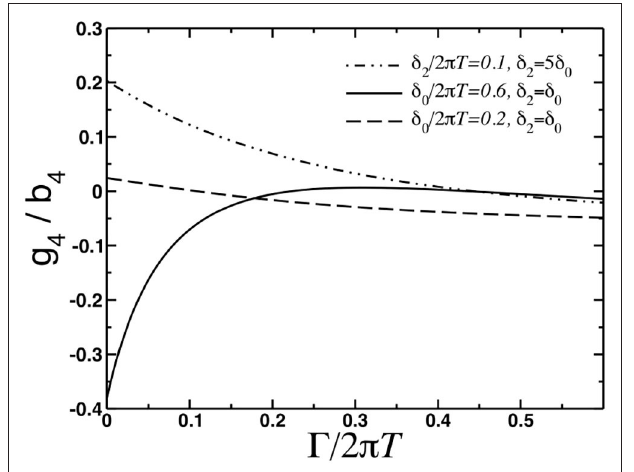
FIGURE 3 | Plot of the nematic coupling constant g 4 which appears in free energy as a function of the disorder scattering rate for various values of the parameters δ 0 and δ 2 .